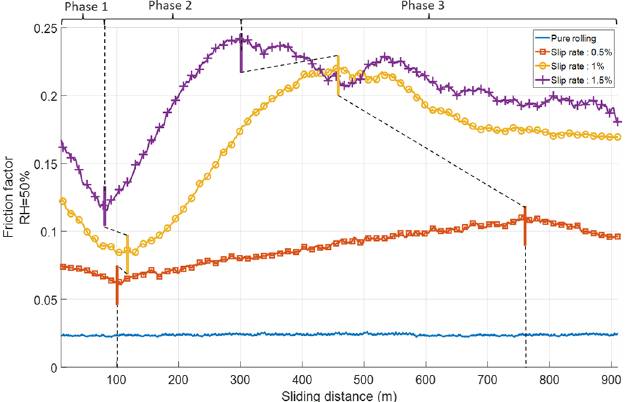
Fig. 12. Friction factor as a function of the sliding distance travelled on Triboring tribometer, plane leaves RH = 50%. High- lights of the different phases. Phase 1 extends from the beginning of the test to the point where the minimum friction factor is obtained, phase 2 extends to the point where the maximum fric- tion factor is measured, and phase 3 extends to the point where a stabilized friction factor is obtained (corresponding to the end of a test).